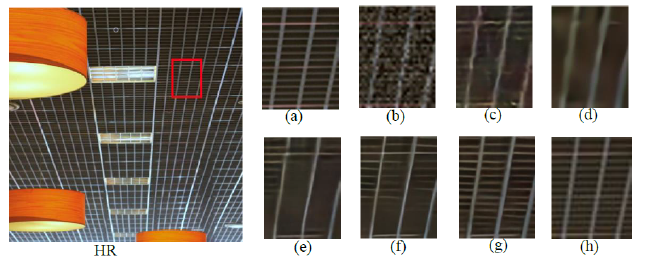
Figure 4. Qualitative comparison between our EMTCM and state-of-the-art SR models with the scale factor of 3. ( a ) HR ( b ) Bicubic ( c ) FSRCNN ( d ) LapSRN ( e ) VDSR ( f ) RDN ( g ) SRFRN ( h ) Ours. Best viewed zoomed in.